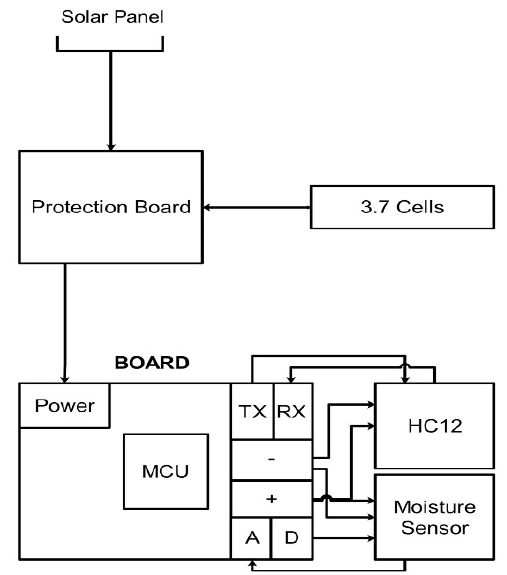
Figure 2. Hardware design of sensor node.